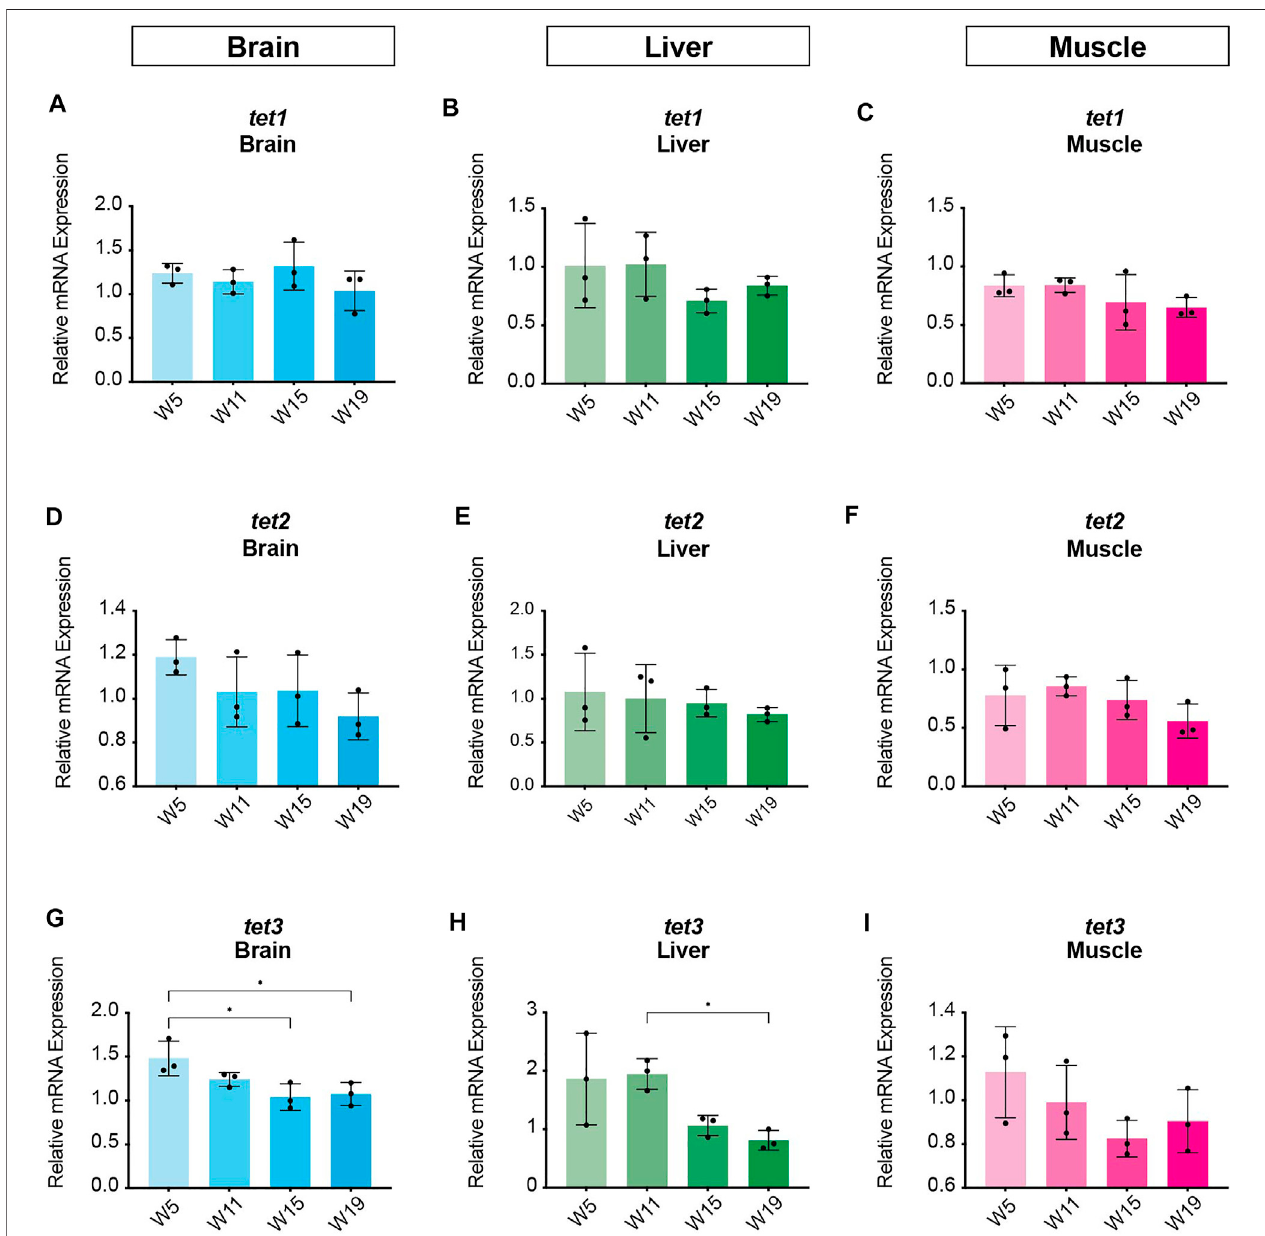
FIGURE 6 | Age-dependent gene expression pro fi ling of the killi fi sh ten-eleven translocation methylcytosine dioxygenase family. Quantitative Real-time PCR of killi fi sh tet1 (A – C) , tet2 (D – F) , tet3 (G – I) in brain, liver and muscle at 5(W5), 11(W11), 15(W15), and 19 (W19) weeks ofage.Individual tet expression wasnormalized to tbp housekeeping gene expression. All error bars represent SD of three biological replicates. Statistical signi fi cances were calculated with one-way ANOVA using Tukey ’ smultiplecomparisonscomparingthemeansofalltimepointswitheachother.RelativemRNAexpressionisshown.ns: p > 0.05;*: p ≤ 0.05;** p ≤ 0.01;***: p ≤ 0.001; ****: p ≤